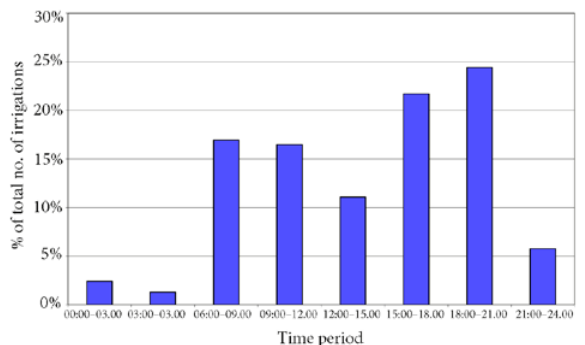
Fig. 5. Percentage of total number of irrigation at different times during the trial